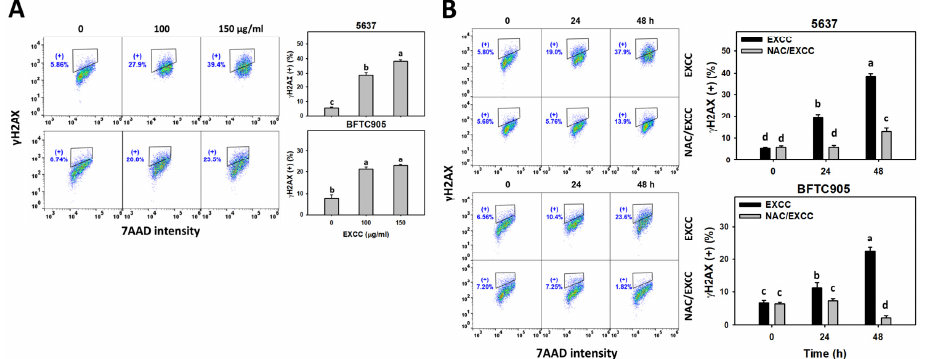
Figure 10. γ H2AX change by EXCC. ( A ) γ H2AX assay of EXCC. Two bladder cancer cell lines (5637 and BFTC905) were tested. Cells were treated with solvent control (0.1% DMSO) and EXCC (100 and 150 μ g/mL) for 48 h. (+) represents the γ H2AX (+) population. ( B ) γ H2AX assay of NAC/EXCC. NAC/EXCC is the NAC pretreatment (10 mM, 1 h) coupled with EXCC posttreatment (150 μ g/mL, 24 and 48 h). Statistical lower-case letters were given to each treatment. Non-overlapping letters between different treatments indicate significant results ( p < 0.05). Data, means ± SD ( n = 3). For example (5637 cells in Figure 10B), the EXCC (black color) 0, 24, and 48 h indicating “d, b, and a” show significant results between each other because these letters were non-overlapping. In contrast, EXCC 0 (black color) and NAC/EXCC (gray color) 0 h indicating “d” show nonsignificant results because these letters overlap.